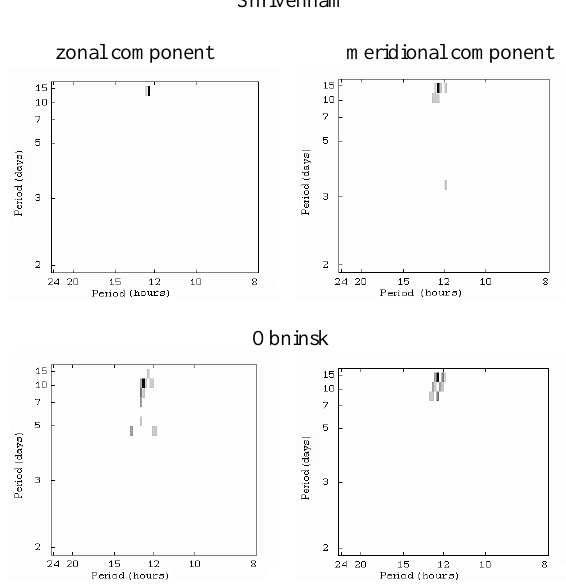
Fig. 15. Bispectra estimated for the hourly wind data of Shrivenham and Obninsk measured during December